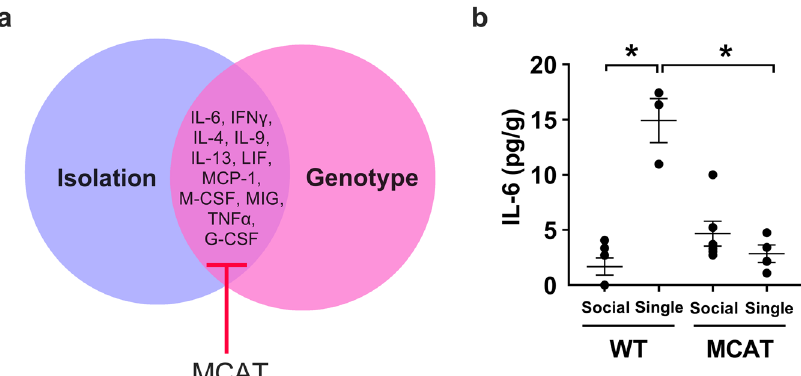
Fig. 2 Cytokines showing higher expression in hippocampus due to isolation and mitigation in MCAT mice. a Eleven out of 44 cytokines were upregulated in wild-type single housed vs social-housed mice and mitigated in MCAT single housed mice. b Representative graph (IL-6) of one of the 11 cytokines elevated due to isolation and mitigated in MCAT mice. Here and in succeeding dot plots, the longer horizontal line in the dot plot corresponds to the group mean while the shorter horizontal lines depict the standard error (SE). Sample sizes are WT NL social ( n = 6), WT NL single ( n = 3), MCAT NL social ( n = 6), and MCAT NL single ( n = 4). Some data points overlap. A fi t model was generated to include housing state, genotype, loading state, and their pairwise interactions. Interaction effects between housing state and genotype were assessed at p < 0.05. *Statistically signi fi cant at p < 0.05 by Tukey post hoc